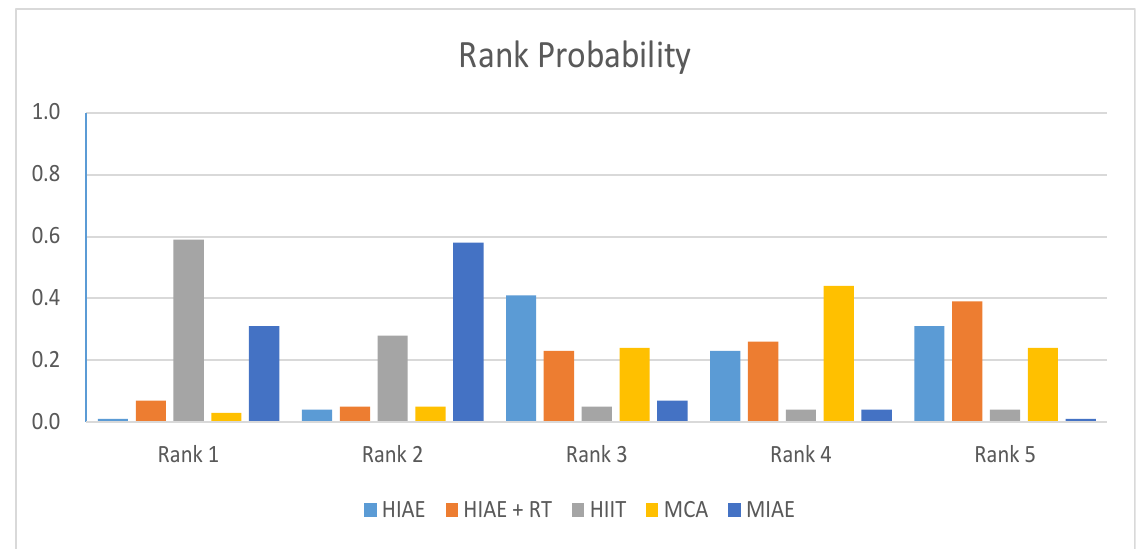
Figure 6. The probability rank of each intervention for unhealthy participants. Table 3. The probability rank of each intervention for unhealthy participants. Intervention Rank 1 Rank 2 Rank 3 Rank 4 Rank 5 HIAE 0.01